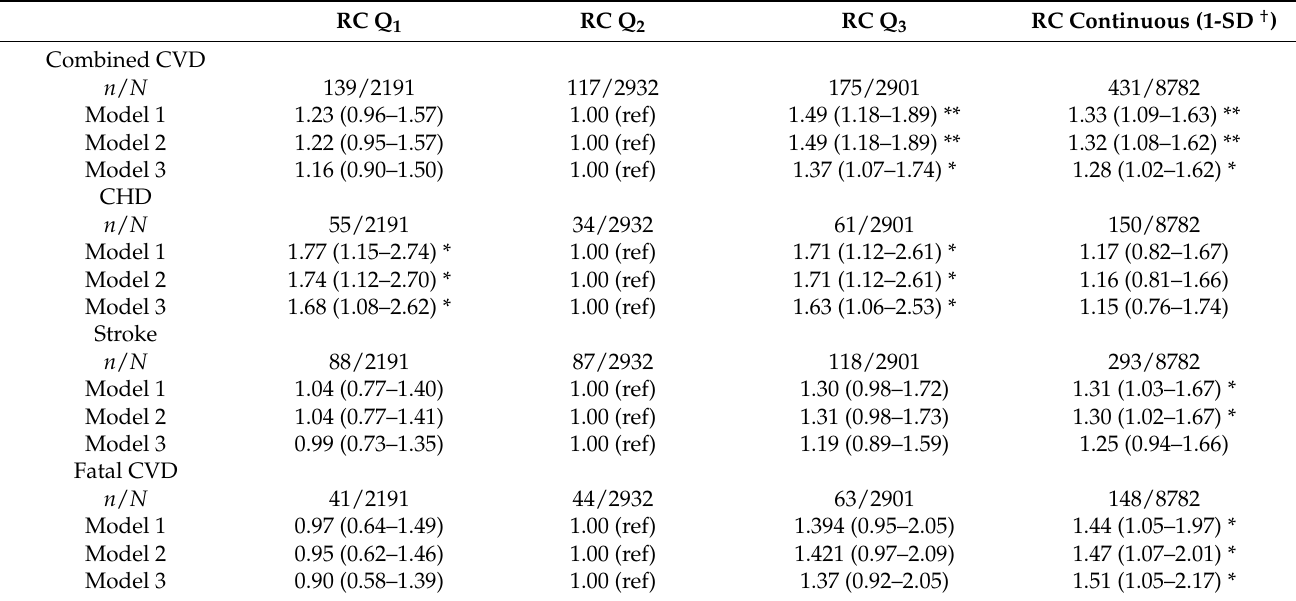
Figure 1. Unadjusted Kaplan–Meier curves for incident cardiovascular events stratified by different levels of remnant cholesterol. The whole cohort was divided into three groups due to different levels of remnant cholesterol. Low level: Tertile I; Medium level: Tertile II; High level: Tertile III. CHD: coronary heart disease; CVD: cardiovascular disease. Table 2. Multivariate-adjusted hazard ratios and 95% confidence intervals for cardiovascular outcomes associated with baseline remnant cholesterol.